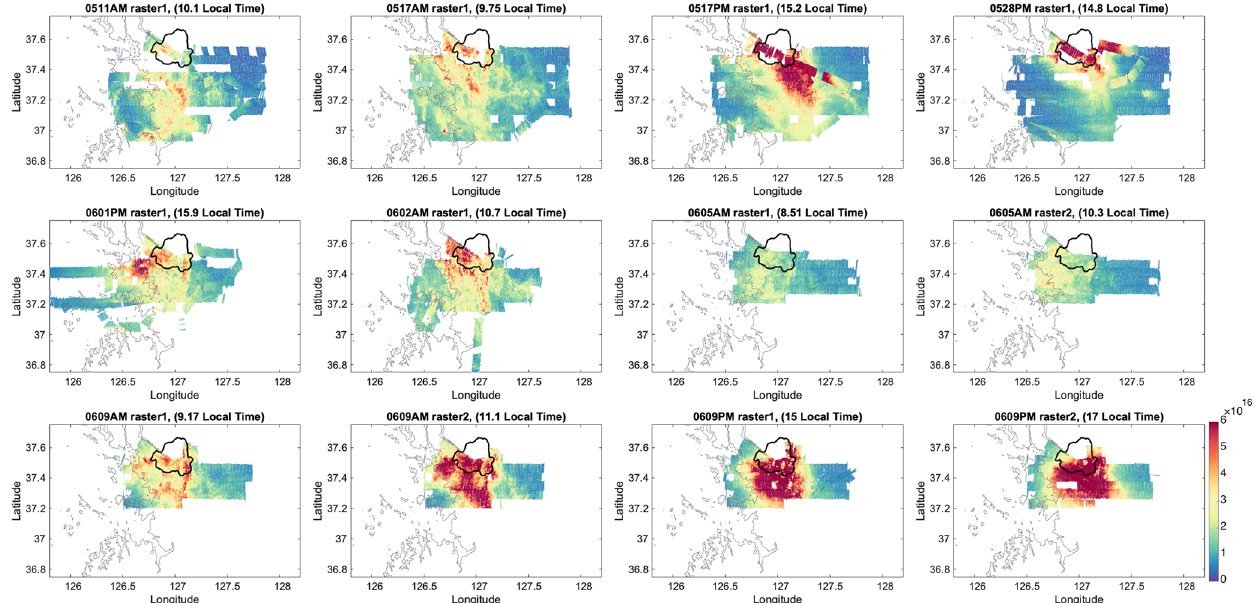
Figure 2. GeoTASO data of tropospheric NO 2 vertical column (molec.cm − 2 ) measured during KORUS-AQ over the Seoul region. Each panel shows a separate raster. Panel titles show month, day, AM/PM, raster number on that date, and mean time of raster acquisition. There were nine flights sampling rasters over Seoul. The 1 May AM, 17 May AM, 17 May PM, 28 May PM, 1 June PM, and 2 June AM flights each sampled one raster. The 5 June AM, 9 June AM, and 9 June PM flights each sampled two rasters. As a result, there were two flights and two rasters on 17 May, one flight and two rasters on 5 June, and two flights and four rasters on 9 June. The bold polygons in each panel represent the political boundary of